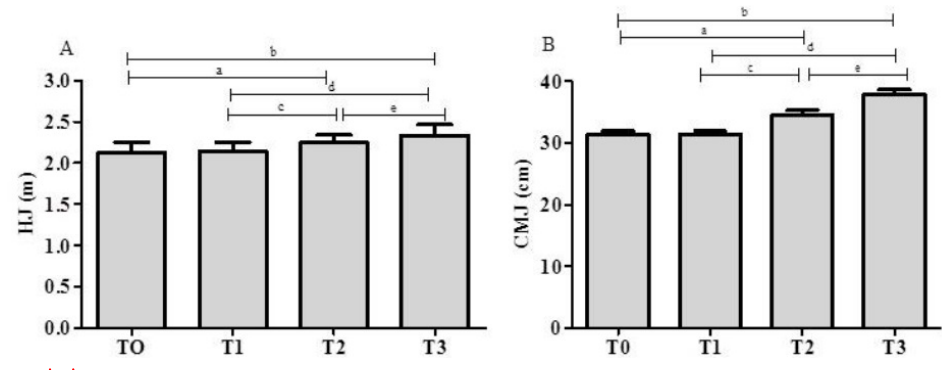
Figure 4. Performances in